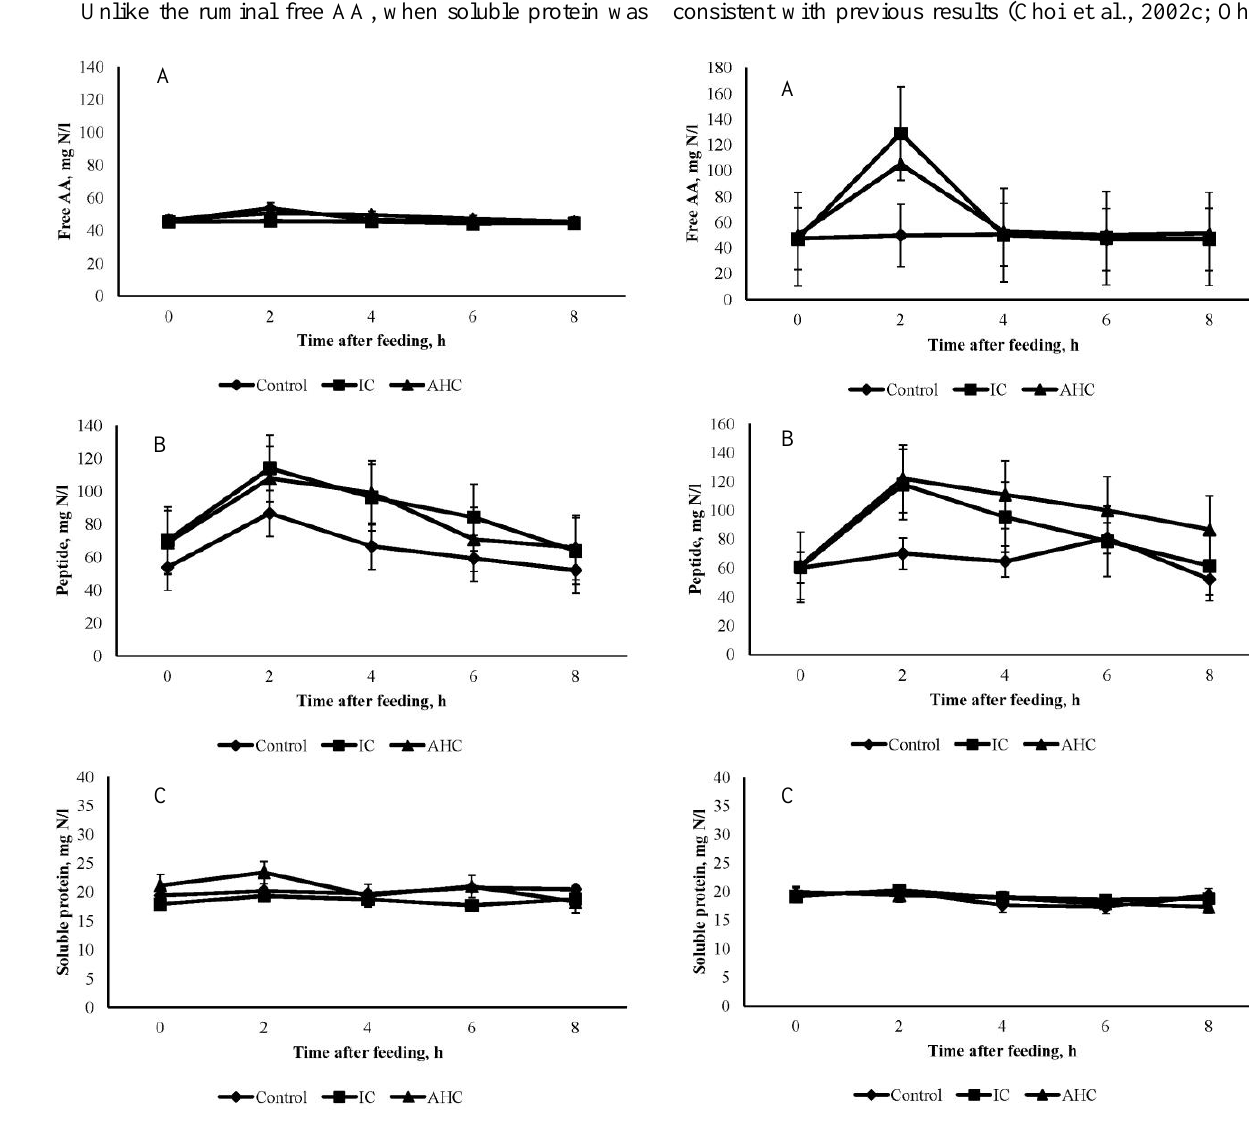
Figure 2. Diurnal pattern in concentration of free amino acids (AA) (A), peptide (B) and soluble protein (C) in the liquid phase of omasal digesta (OD) during a feeding cycle as influenced by soluble protein supplements (Markers indicate no supplement (  ), intact casein (■) and acid hydrolyzed casein (▲),